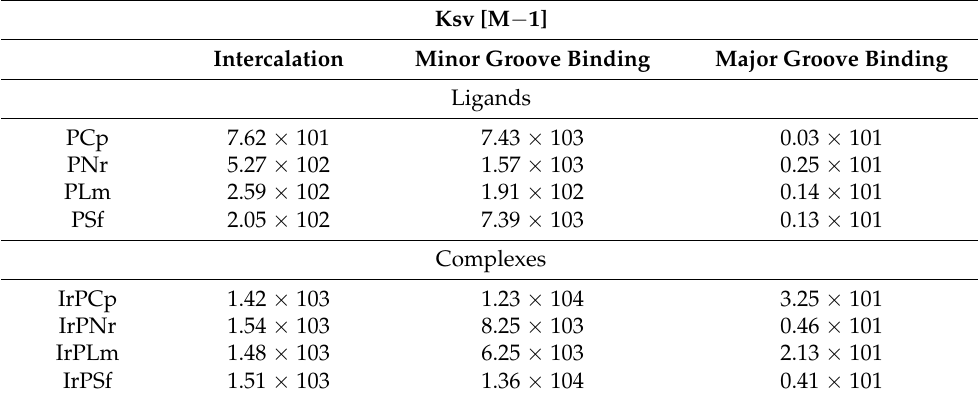
Table 1. Determined Ksv values for the studied phosphines and Ir(III)